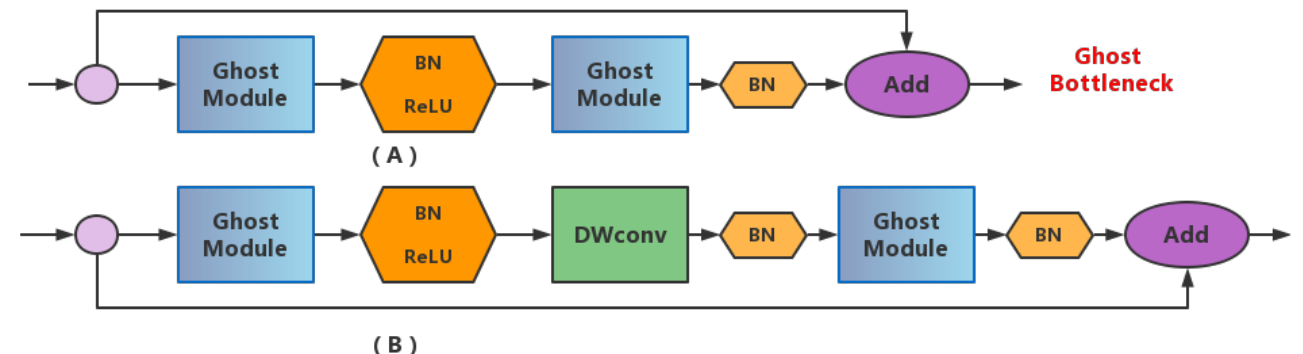
Figure 4. The structure diagram of Ghost Bottleneck. BN means that Batch Normalization layer. Add operation means that the superposition of information. ReLU means that the Rectified Linear Unit. ( A ) Stride = 1 ( B ) Stride = 2. DWconv means that the depthwise separable convolution.